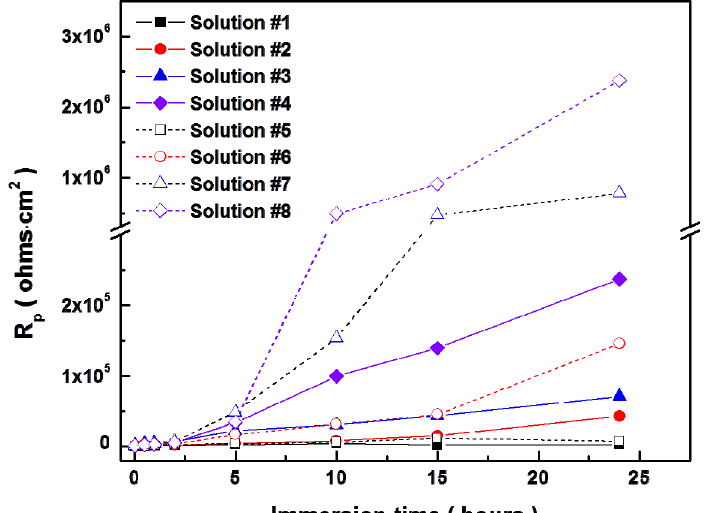
Figure 10. Temporal change of ( a ) coating resistance ( R ( b ) charge transfer resistance ( R modified Gamble’s solutions up to 24